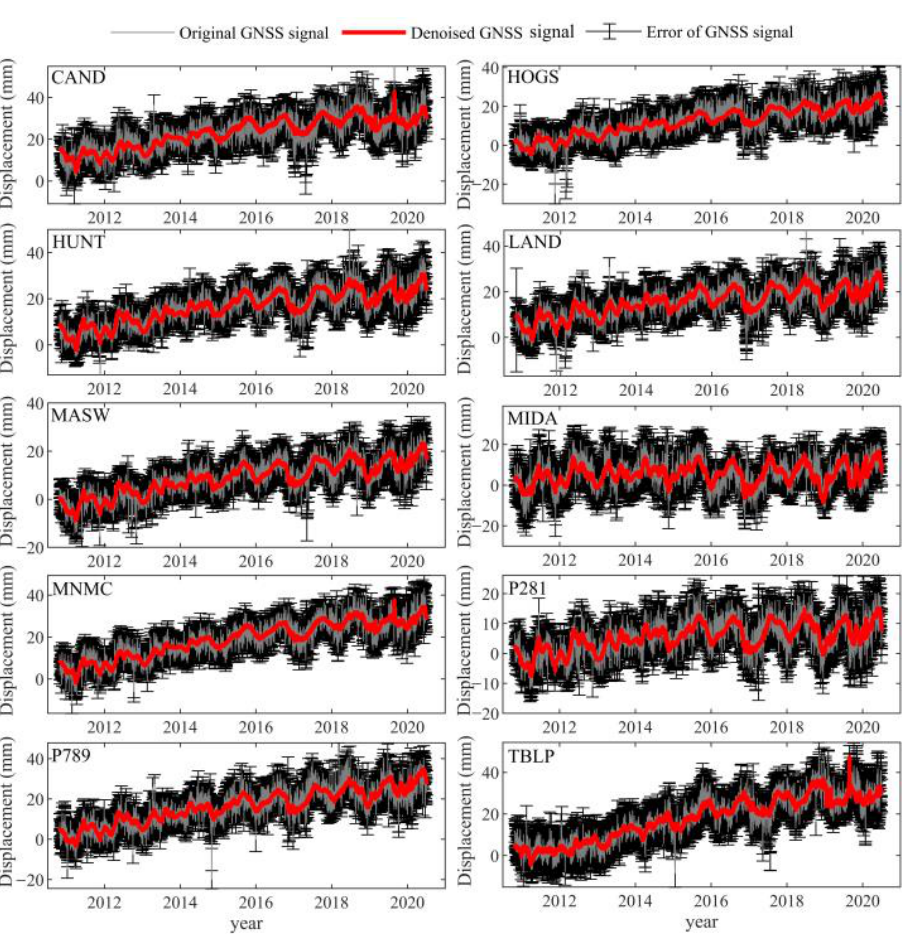
Figure A1. The effect of the developed denoising method in U direction for block 2. The grey lines denote original GNSS daily time series; the red lines denote the denoised GNSS daily time series; and the black I-shapes indicate errors with corresponding to GNSS positions.